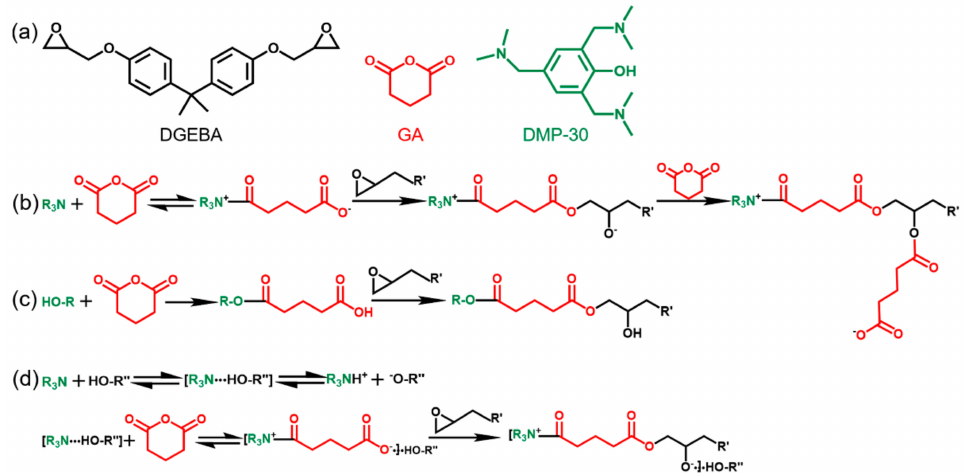
Figure 2. Curing reaction mechanisms of DGEBA and GA under the catalysis of DMP-30: ( a ) Detailed chemical structures of DGEBA, GA, and DMP-30; ( b ) The tertiary amine is able to open the anhydride ring to form carboxylate anion, which then opens the epoxy ring to yield ester and new alkoxide anion. The new anion then reacts with another anhydride; ( c ) The hydroxyl opens the anhydride ring to form a carboxylic group, which further reacts with the epoxy group and generate a new hydroxyl; ( d ) The tertiary amine, nonphenolic hydroxyl, and anhydride form a complex, which enhances the reactivity between the epoxy group and the